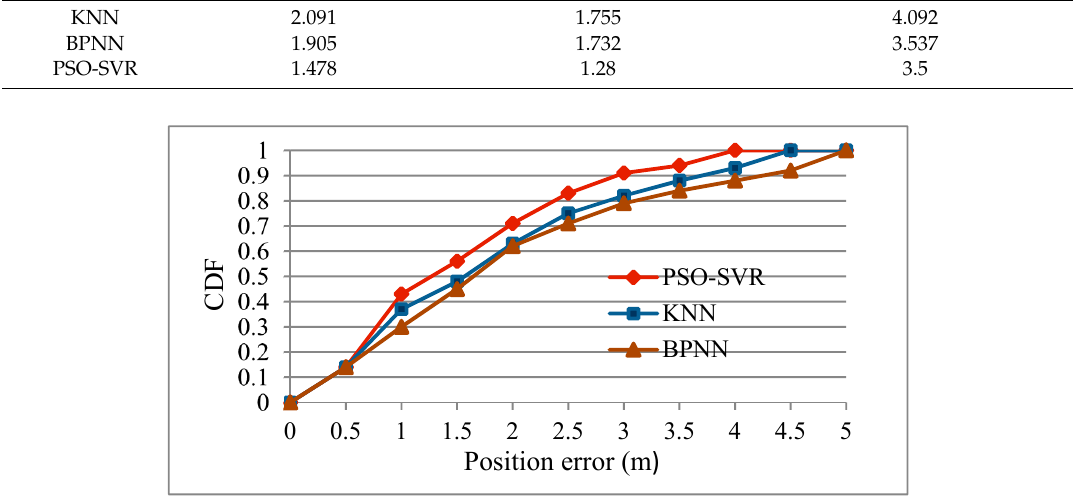
Figure 10. CDF with different localization algorithms.